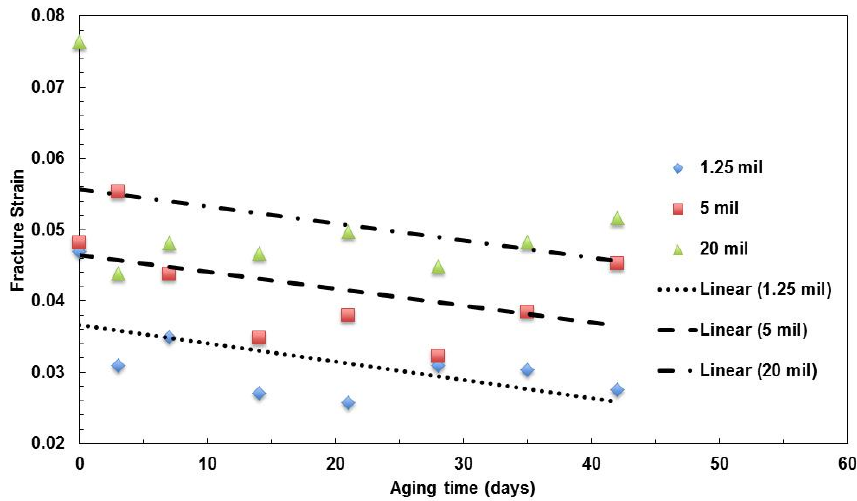
Figure 7. Summary of the change in fracture strain with aging time for films with various film thicknesses aged at 100 °C.